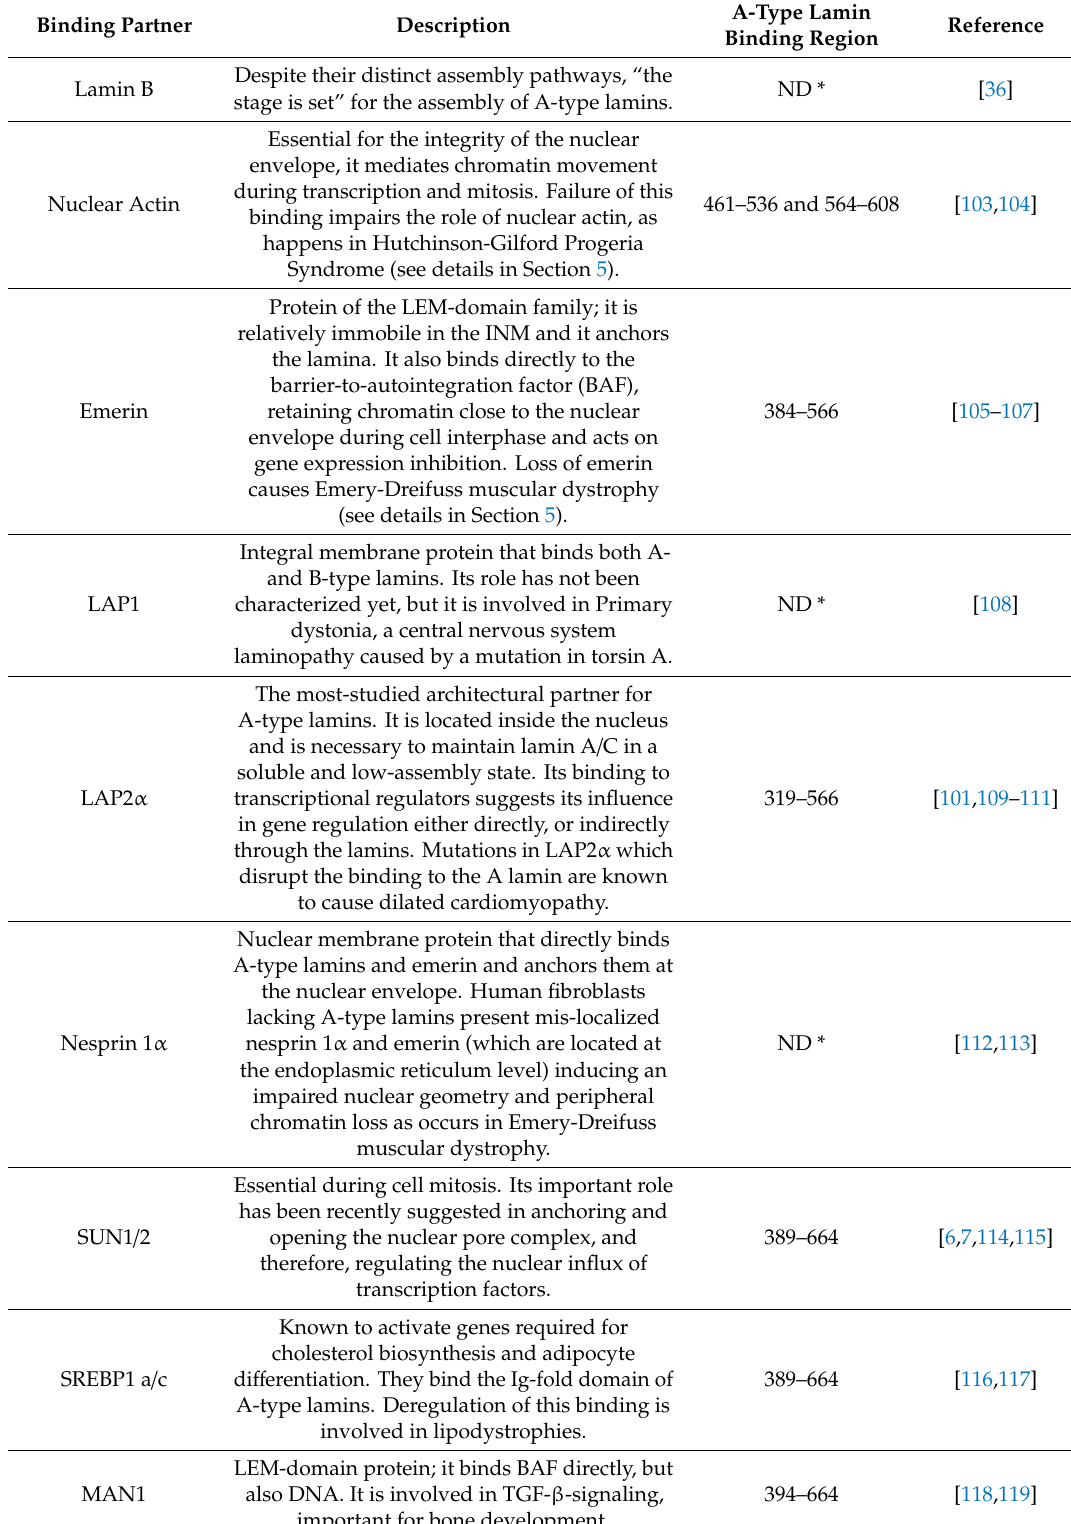
Table 3. Main binding partners of human lamin A /